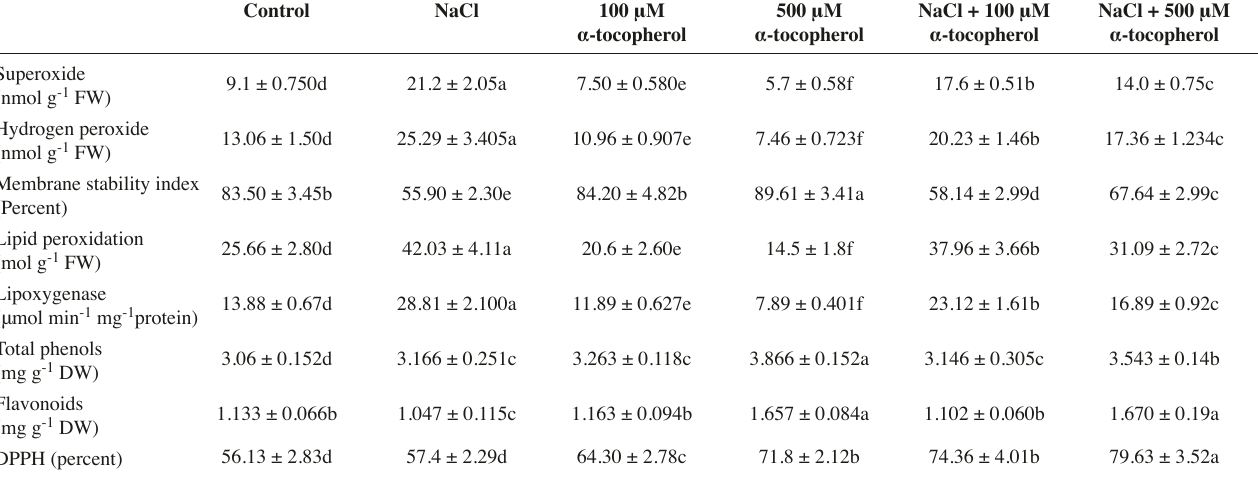
Tab. 2: Effect of salinity (100 mM NaCl) with and without exogenous application of α-tocopherol (100 and 500 μM ) on superoxide, hydrogen peroxide, memb- rane stability index, lipid peroxidation, lipoxygenase activity, total phenols, total flavonoids and total antioxidant activity (DPPH) in soybean ( Glycine max ). Values are mean (±SE) of five replicates and different letters represent significant difference at